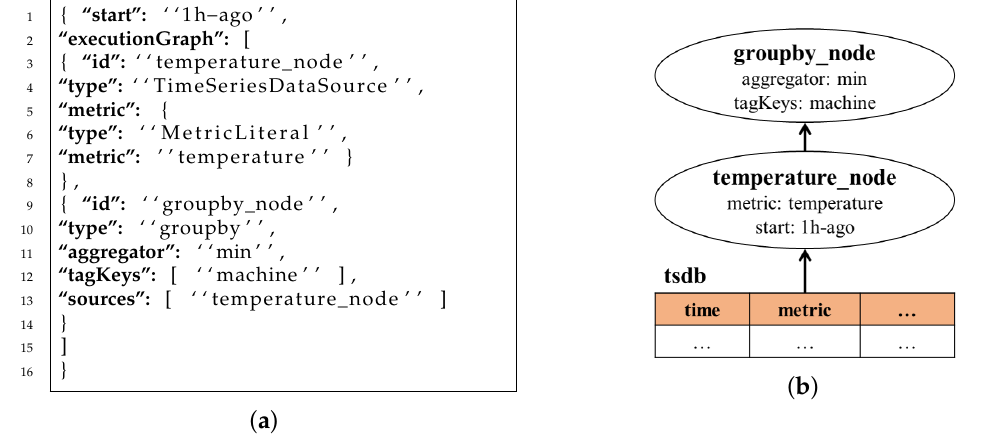
Figure 7. Data retrieval in OpenTSDB. ( a ) query in JSON, ( b ) execution graph.